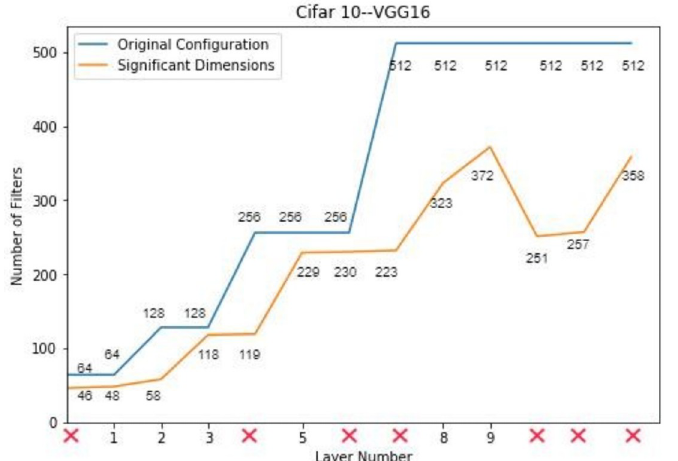
Fig 4. Compressed architecture of VGG-16 on